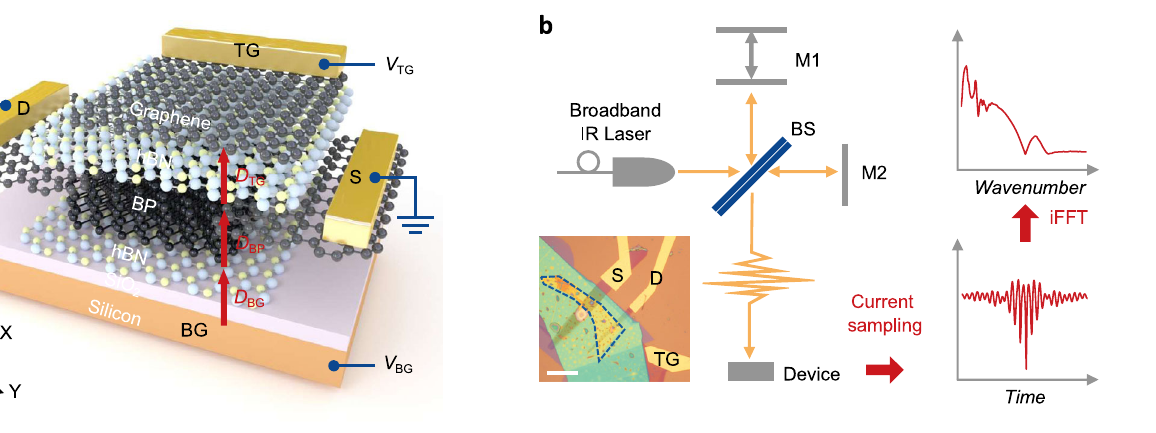
Top panel: under 0.5W/cm 2 and at 200K. The absorption includes an inter-band part and an exciton peak. Middle panel: under 32W/cm 2 and at 260K. The absorption continuously extends to low energy region, indicating an intra-band transition.Bottompanel:under160W/cm 2 andat5K.Thehorizontallinesshowthe baselineofzeroabsorption.Theturquoiseandredregionsindicateabsorptionand gain. Source data are provided as a Source Data fi le. c Schematic of conduction band structure with different interaction strength. With increasing correlation interaction, the conduction band splits into two bands with a Mott gap. E F Fermi energy, E B exciton binding